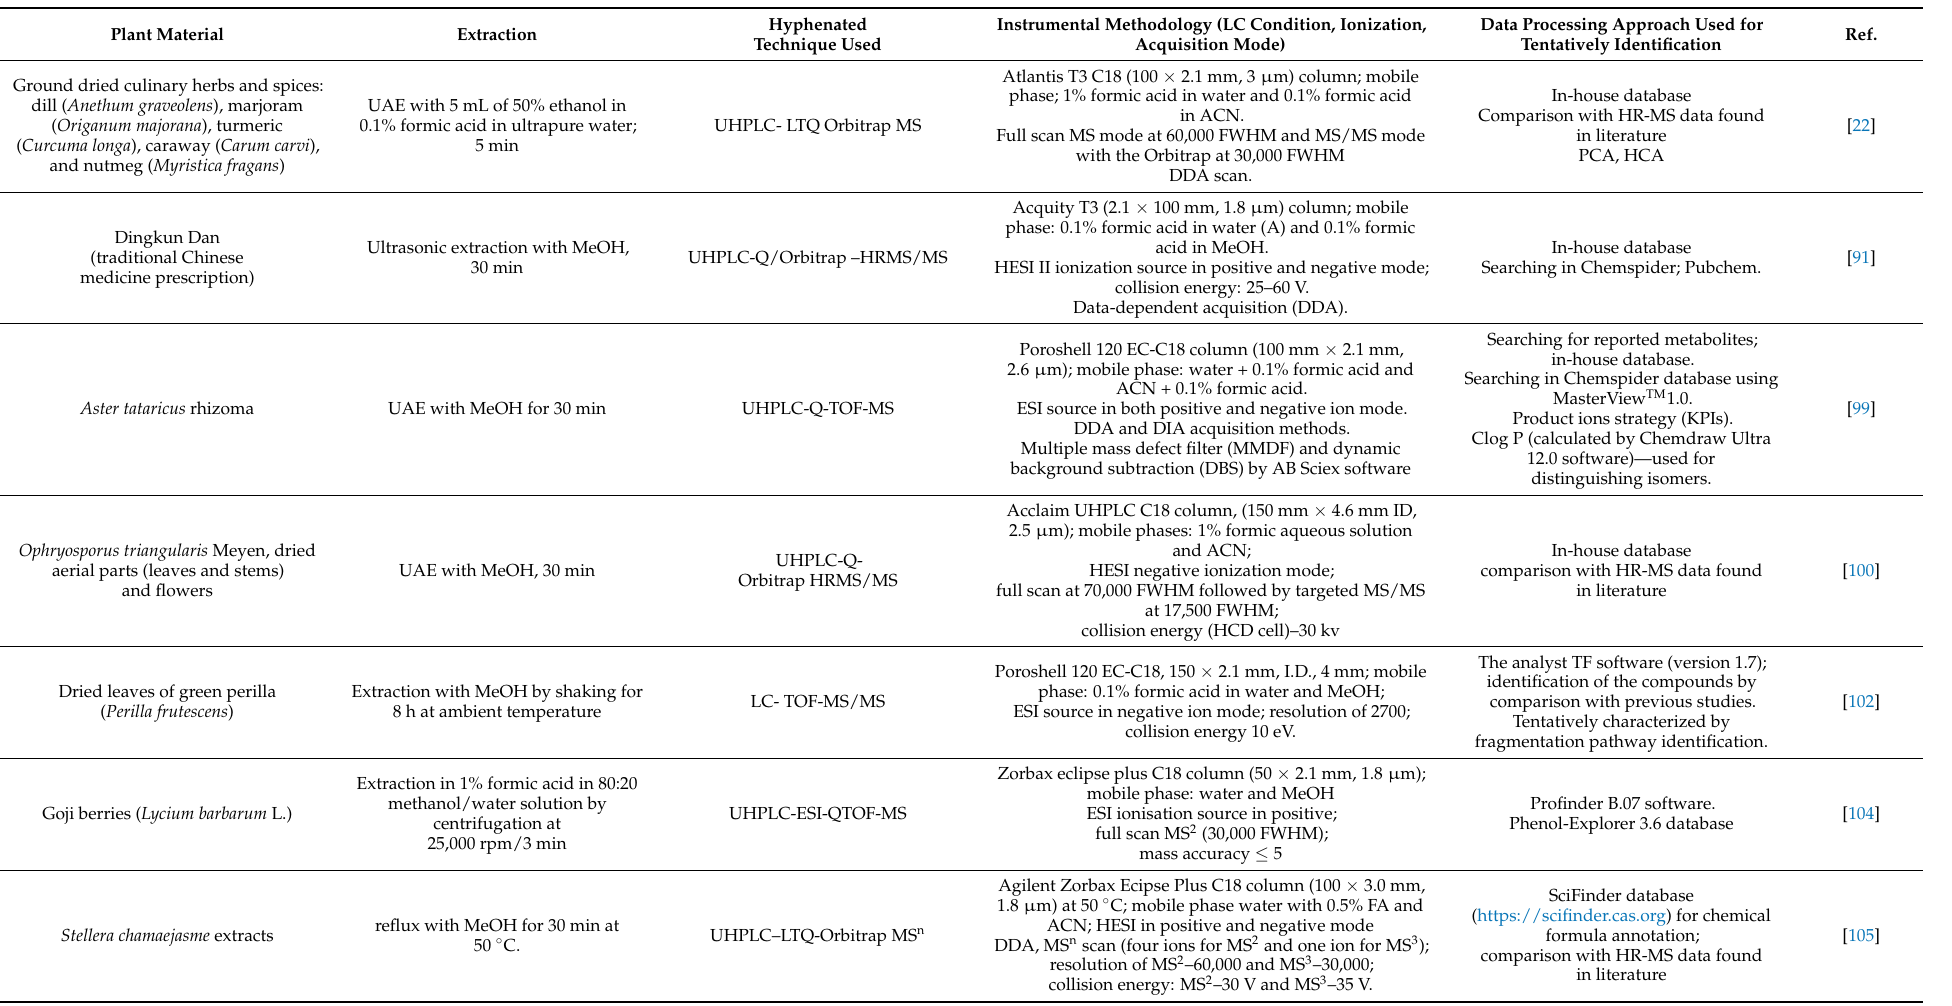
Table 3. Examples of the non-target screening methods used for chemical profiling of the plant